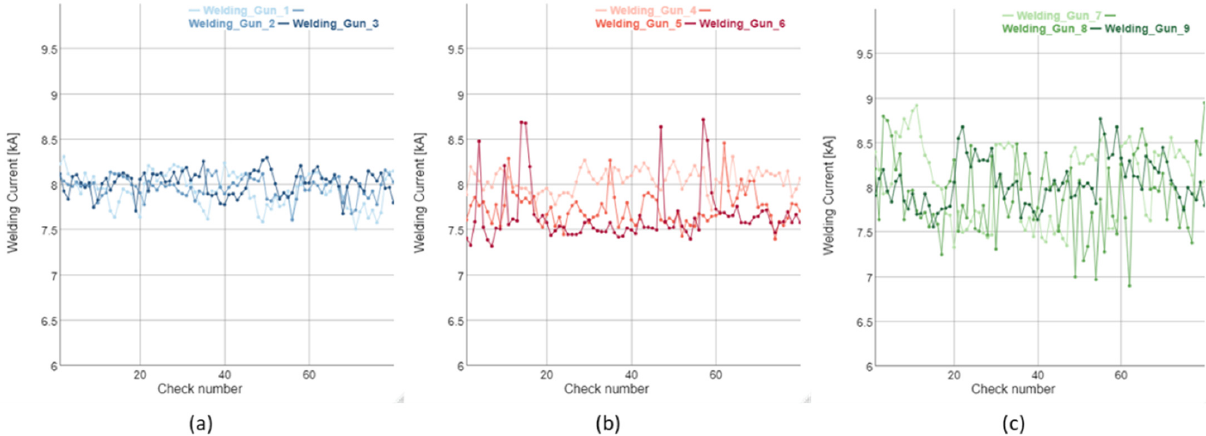
Figure 10. Examples of current measured depending on the cluster for different welding guns. ( a ) Cluster 3, determined as correct operation, ( b ) Cluster 1, determined as pre-alarm, ( c ) cluster 2, de- termined as alarm.